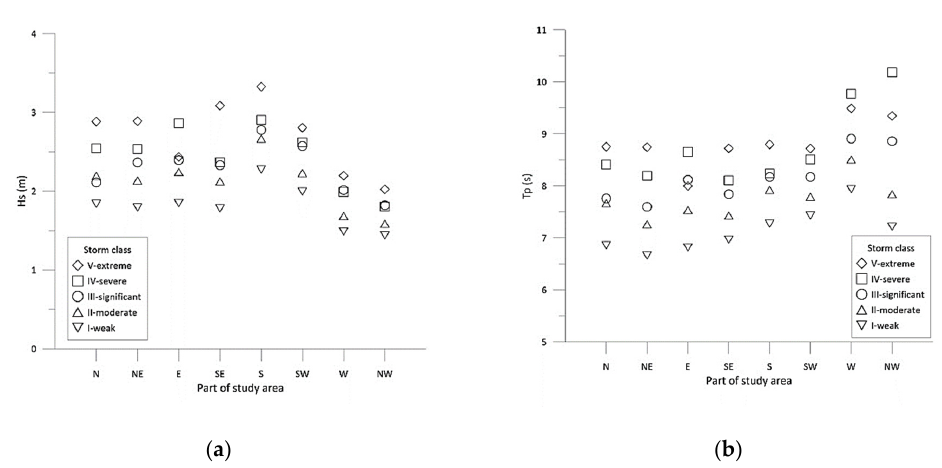
Figure 5. Average ( a ) significant wave height and ( b ) peak period for each storm class per geographical section of study area.